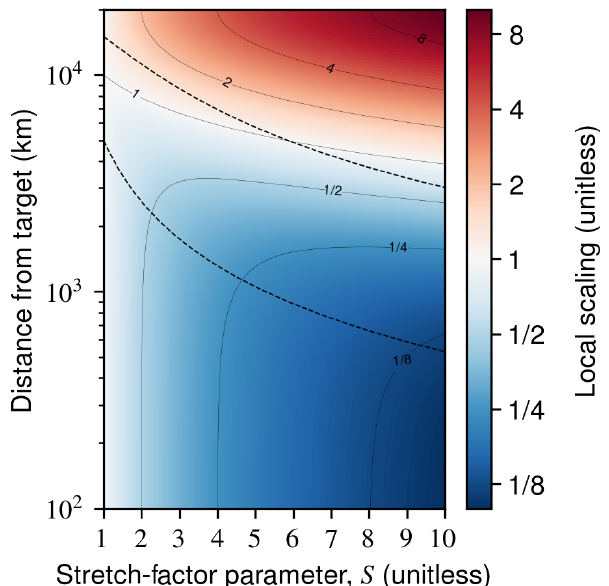
Figure 3. Local scaling as a function of distance from the target point, for stretch factors in the range 1–10. The dashed lines show the distance from the target point to the cubed-sphere face edges after stretching. The lower dashed line is the distance to the center of the target face’s edges, and the upper dashed line is the distance to the center of the opposite face